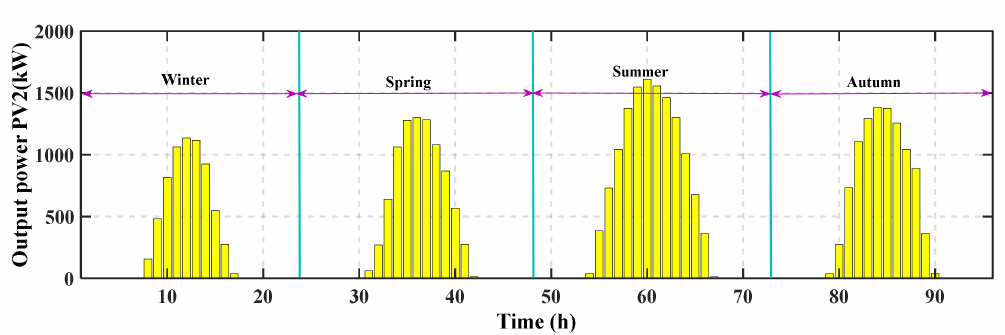
Figure 11. The outputted power from the second unit for case 2.